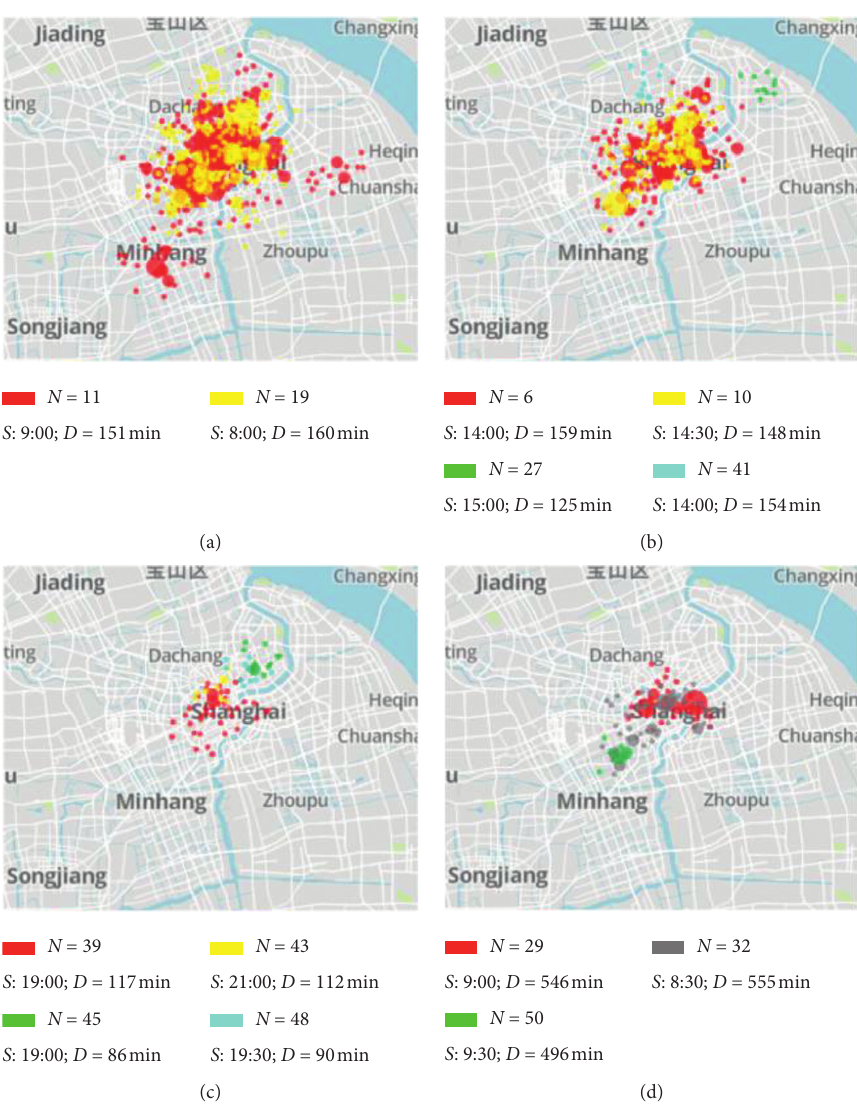
Figure 11: Sample activity pattern related to work. Size of the points represents the relative activity frequency. N : cluster number; S : start time; D : duration. (a) Entertainment in the early morning. (b) Entertainment in the afternoon. (c) Entertainment in the evening. (d) Long time